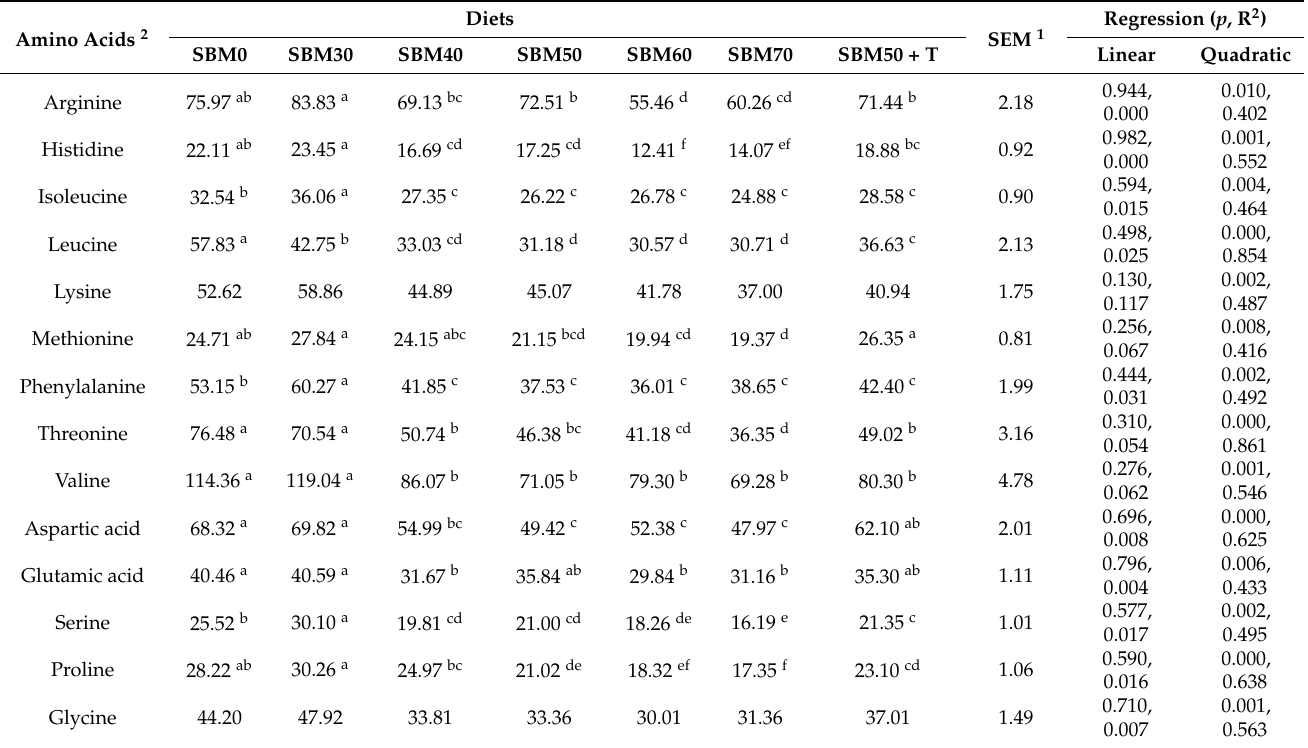
Table 8. Essential amino acid (EAA) retention (%) of juvenile Oplegnathus punctatus fed diets contain- ing difference levels of SBM and